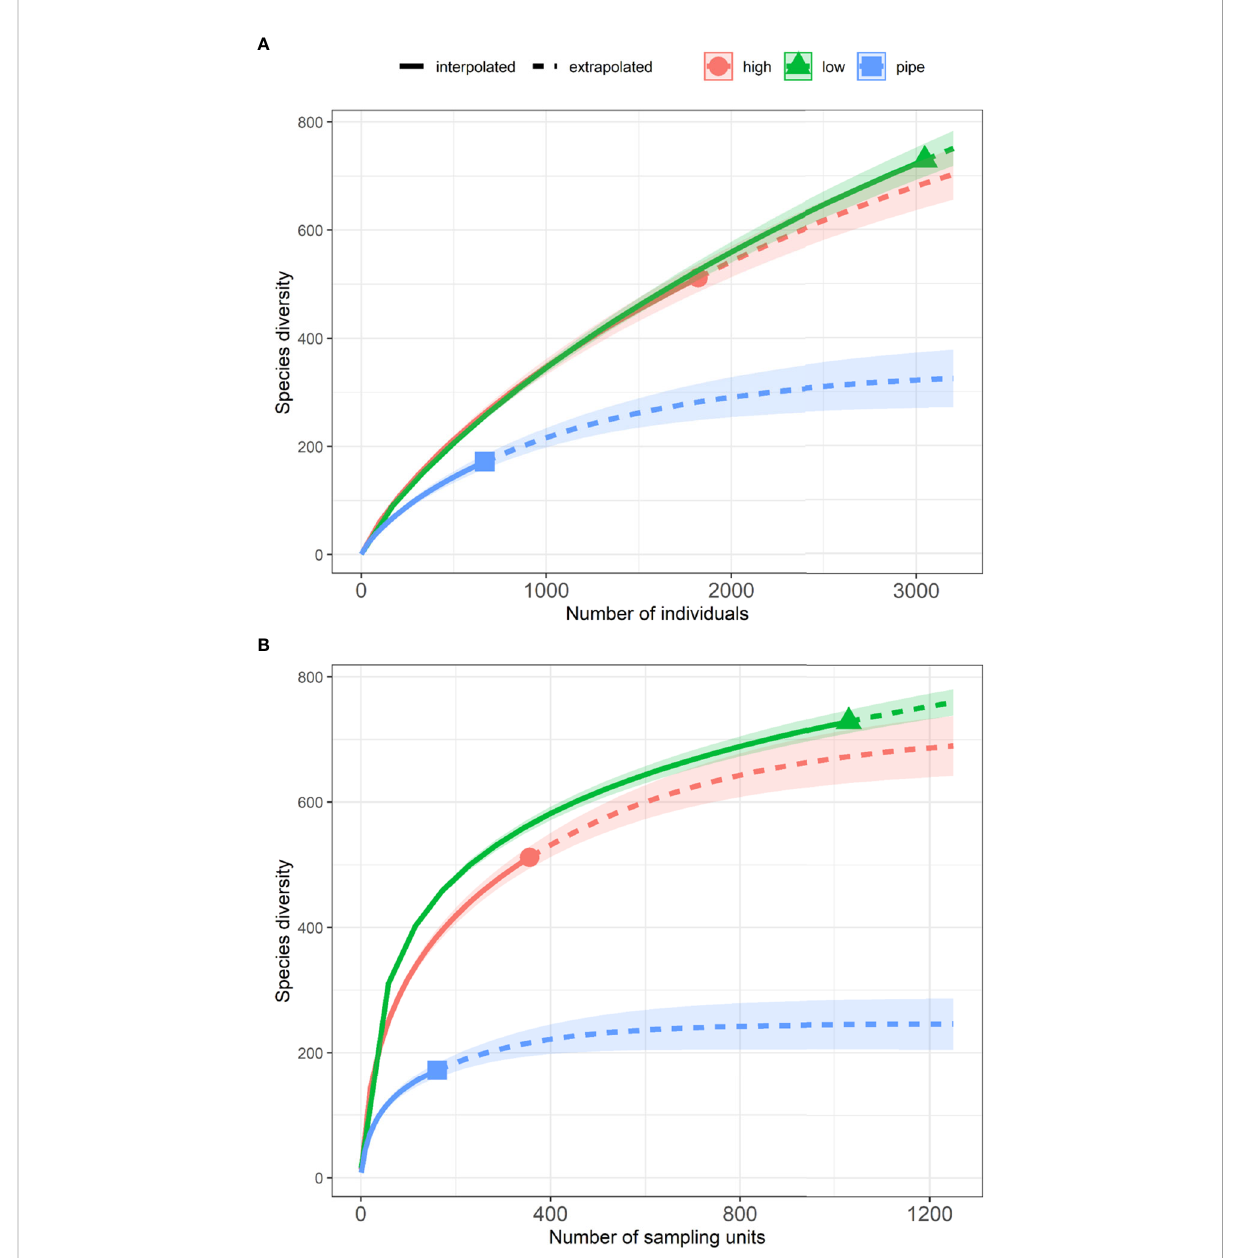
FIGURE 6 (A) Individual-based and (B) Sample-size-based rarefaction (solid lines) and extrapolation (dotted lines) sampling curves with 95% con fi dence intervals (shaded areas) for the species diversity (number of taxa) data across three sea fl oor complexities: pipelines, low complexity natural habitat and high complexity natural habitat. Solid line indicates the rare fi ed curve, dashed line indicates the extrapolated curve, symbol indicates the observed taxonomic richness, the shaded area indicates the 95% con fi dence